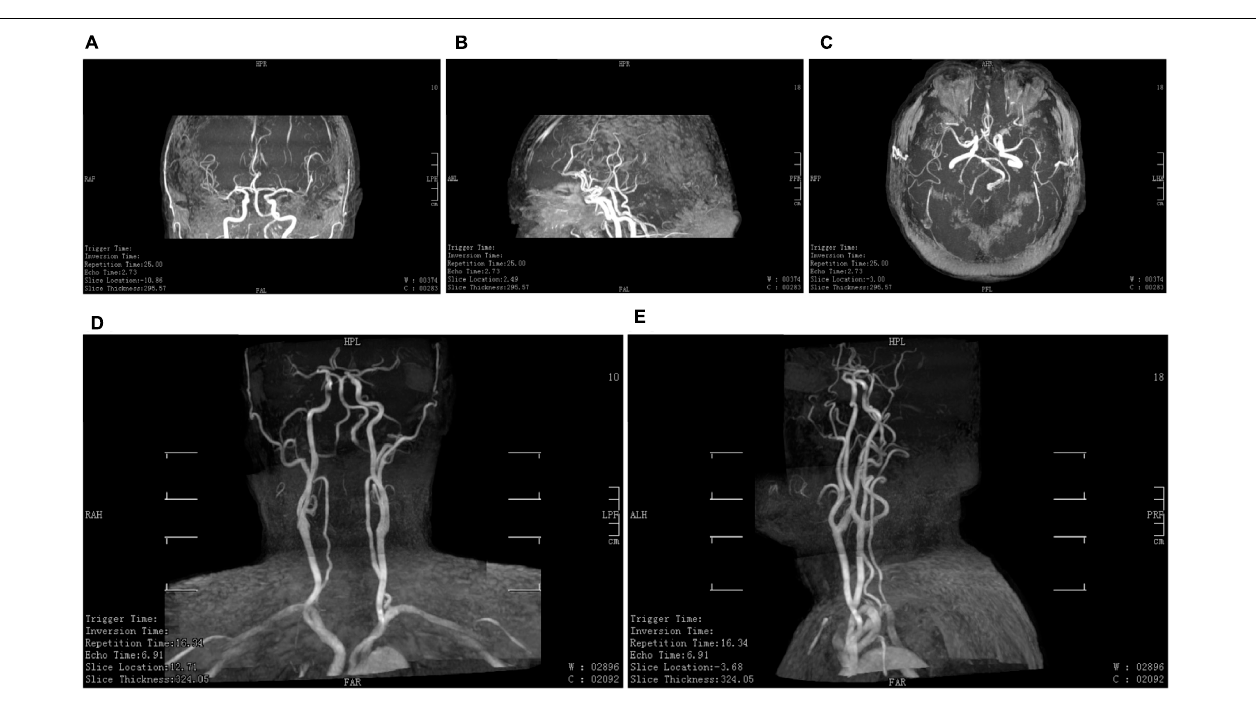
FIGURE 3 | Cerebral vessels in 2020. (A–E) Head and neck magnetic resonance angiography in 2020. The results of his cerebrovascular tests in 2020 were similar to those in